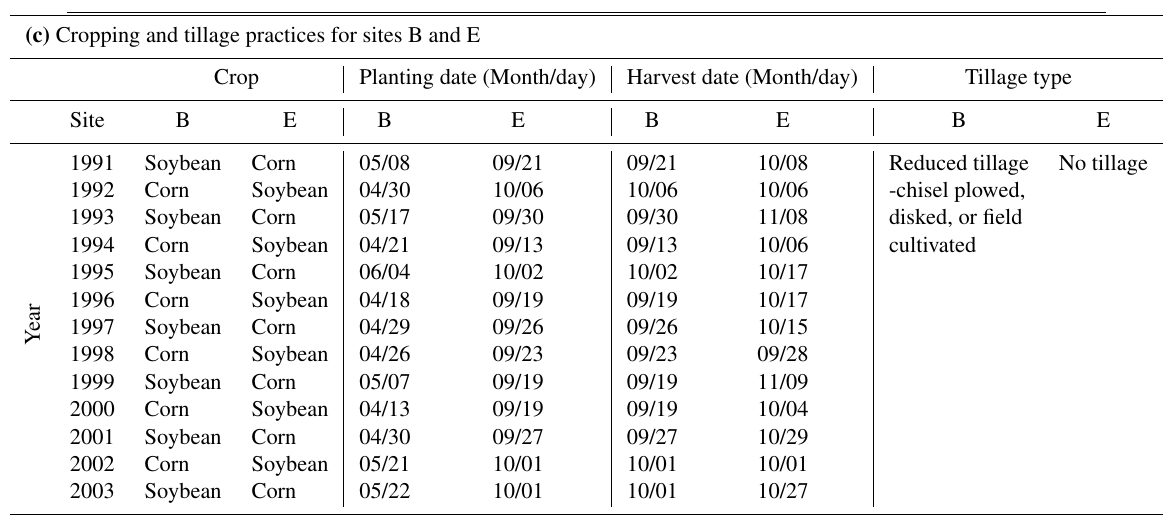
1 USGS: US Geological Survey, 2 SSURGO: Soil Survey Geographic Database, 3 LULC: Land Use/Land Cover, 4 USDA: US Department of Agriculture, 5 ISWS: Illinois State Water Survey, 6 UIUC: University of Illinois at Urbana Champaign, USA, ∗ Tile flow data during 2000 for site B was corrupted and was not used in this